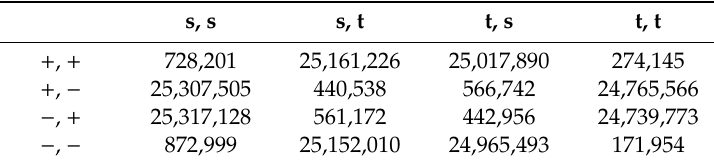
Table 6. Statistics of strand and end distributions.